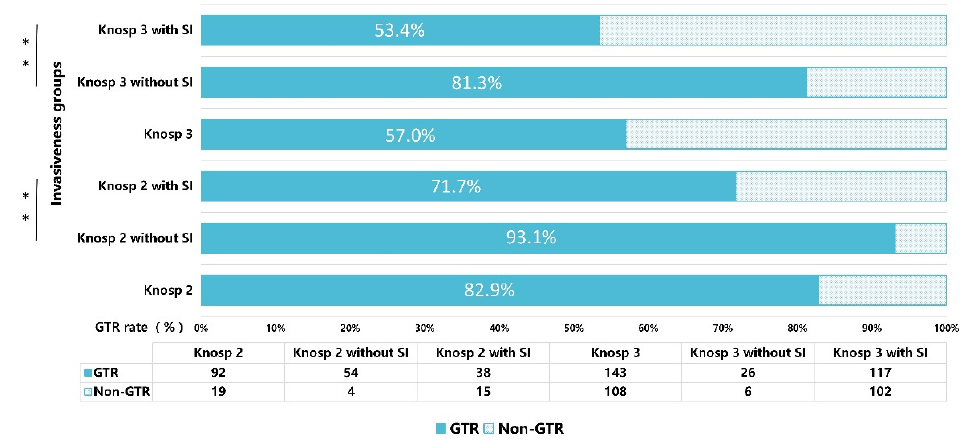
Figure 5. Bar chart illustrating the gross-total resection (GTR) rates of Knosp grade 2–3 with or without surgical invasiveness. SI: surgical invasiveness. ** p < 0.01.